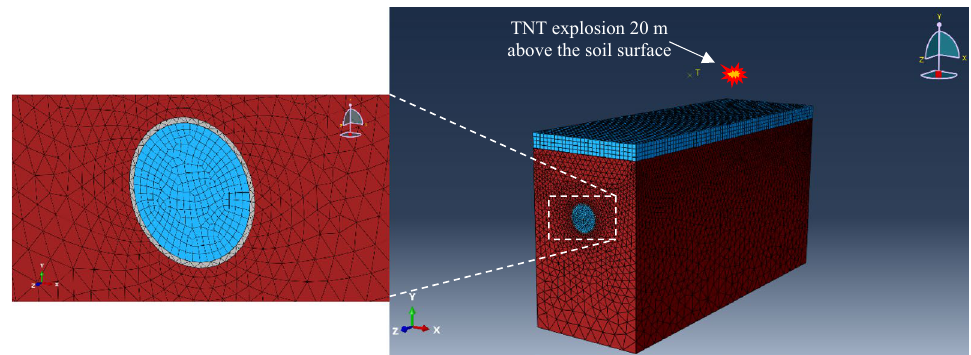
Figure 2. Schematic representation of the underground structure system where red represents the soil, grey represents the lining, and blue represents the air both inside the tunnel and at the